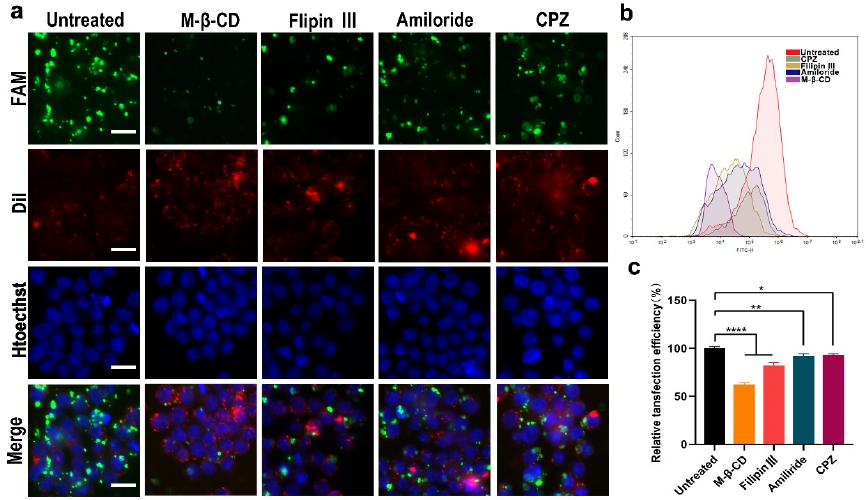
Figure 3. Cell uptake mechanism of the siRNA/LPCE complex. ( a ) Fluorescent image of FAM siRNA/LPCE complex pretreated with different inhibitors. The transfection efficiency in the methyl- β -cyclodextrin treatment group was obviously reduced, FAM is fluorescently labeled siRNA and Dil was used to stain the nucleus and Hoechst was used to stain the cell membrane (scale bar, 25 μ m). ( b , c ) The uptake rates calculated by flow cytometry (* p < 0.05, ** p < 0.01, **** p < 0.0001).